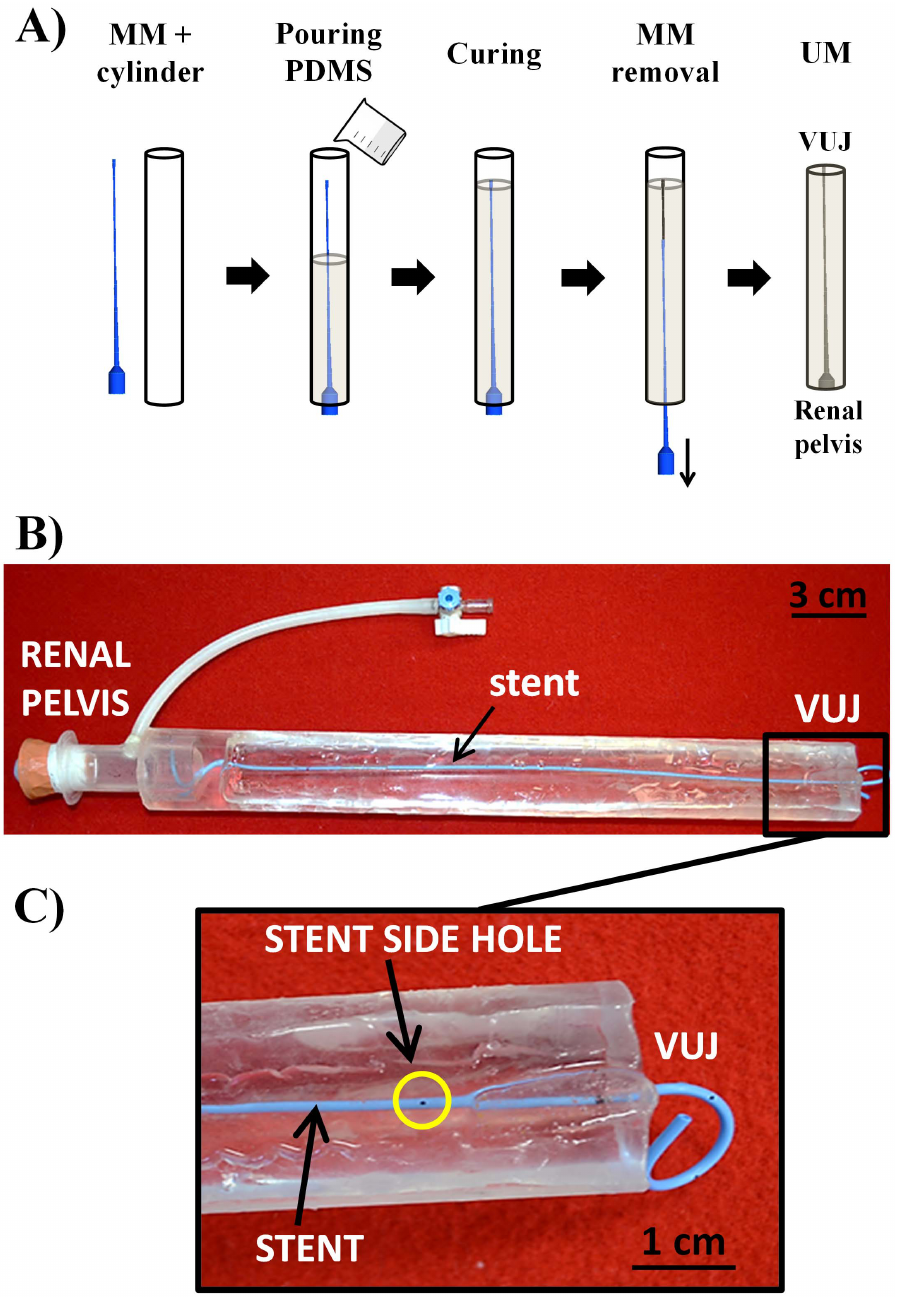
Figure 1. Fabrication of the ureter model. A) Phases of ureter model (UM) fabrication. The male mold (MM) was inserted coaxially into a plastic hallow cylinder. A mixture of PDMS and curing agent was poured into the cylinder and cured at 80 u C for 1 hr. The MM was then extracted from the cylinder and the resulting ureter model was further cured at 100 u C for 30 min. B) Final UM with double-J stent (blue colour) placed inside. C) Particular of the terminal part of UM, in proximity to the vesico-ureter junction (VUJ). Note the presence of side holes and a curling ‘‘J’’ end of the stent. doi:10.1371/journal.pone.0087433.g001 the only variable with which to control the severity of ureteric obstruction. A gap is the space between the hole of the plastic sphere ð 1 Þ and the external surface of the stent (Figure 2C). As an example, OB% = 100 corresponds to A gap = 0, with the all fluid passing through the stent lumen in correspondence to complete obstruc- tion (absence of extra-luminal flow at the obstruction). Where A s =3.4 mm 2 is the stent cross-sectional area, A PShole is the cross-sectional area of the hole in the sphere, and represents